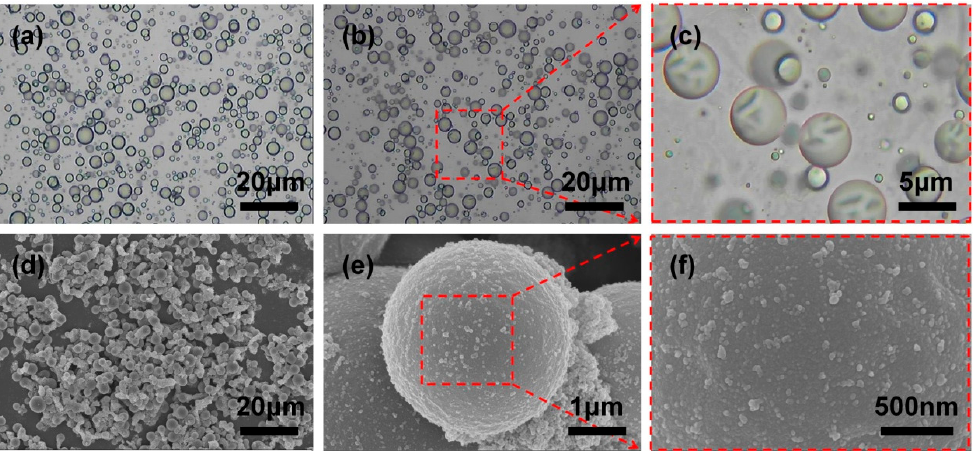
Figure 3. OM micrographs of ( a ) O/W emulsion, ( b , c ) the growth process of MF shell encapsulating IPDI core; ( d – f ) SEM micrographs of IPDI microcapsules with different magnification and micromorphology surface of microcapsule.